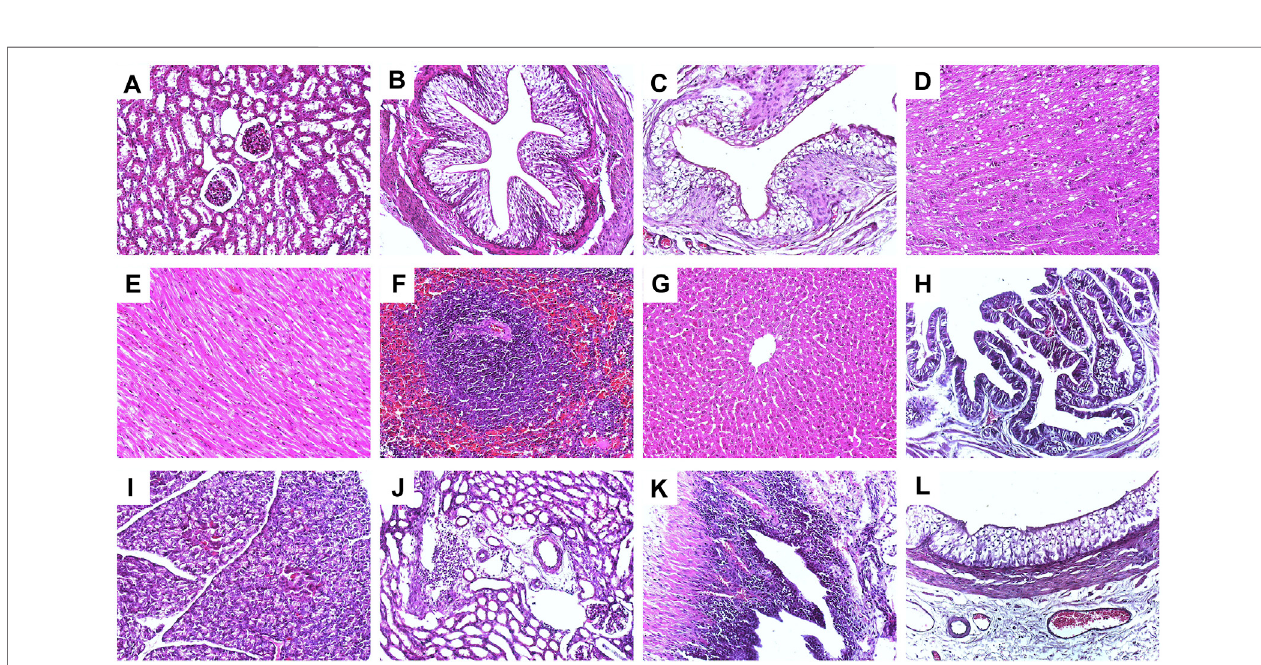
FIGURE7 | Representativehematoxylin − eosin staining histological images ( × 200) ofthe VUR rabbits in the bulking agent injection group; (A) right kidney, (B) right middle of ureter, (C) bladder, (D) brain, (E) heart, (F) spleen, (G) liver, (H) gallbladder, (I) pancreas, (J) left kidney with mild in fl ammatory cell in fi ltration in the renal interstitial, (K) left renal pelvis with mild mucosal edema and mild in fl ammatory cell in fi ltration, and (L) left ureter with mild mucosal edema.